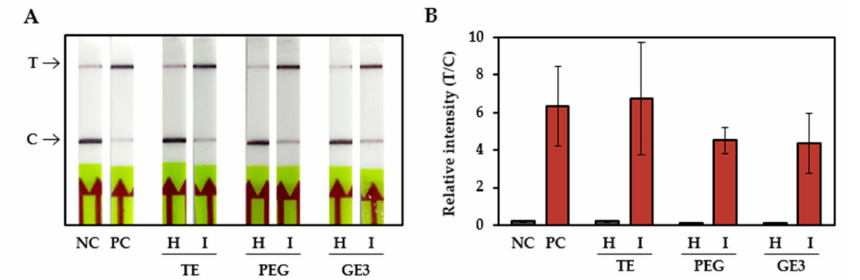
Figure 4. Sensitivity of the RPA-CRISPR/Cas12a-LFA system with crude DNA extracted from infected citrus leaf samples. DNA extracted from fungal pathogens was used as a positive control. ( A ) The LFA strip result for DNA of citrus-scab-infected leaves and healthy citrus leaves extracted with different extraction buffers. ( B ) The relative quantifications of band intensities. The experiments were performed three times, and representative pictures are shown. The error bars indicate the standard deviations. T: test line, C: control line, NC: negative control, no template, PC: positive control, pathogen DNA template, H: healthy sample, I: infected sample, TE: Tris-EDTA buffer, PEG: Polyethylene glycol, GE3: general extraction 3.